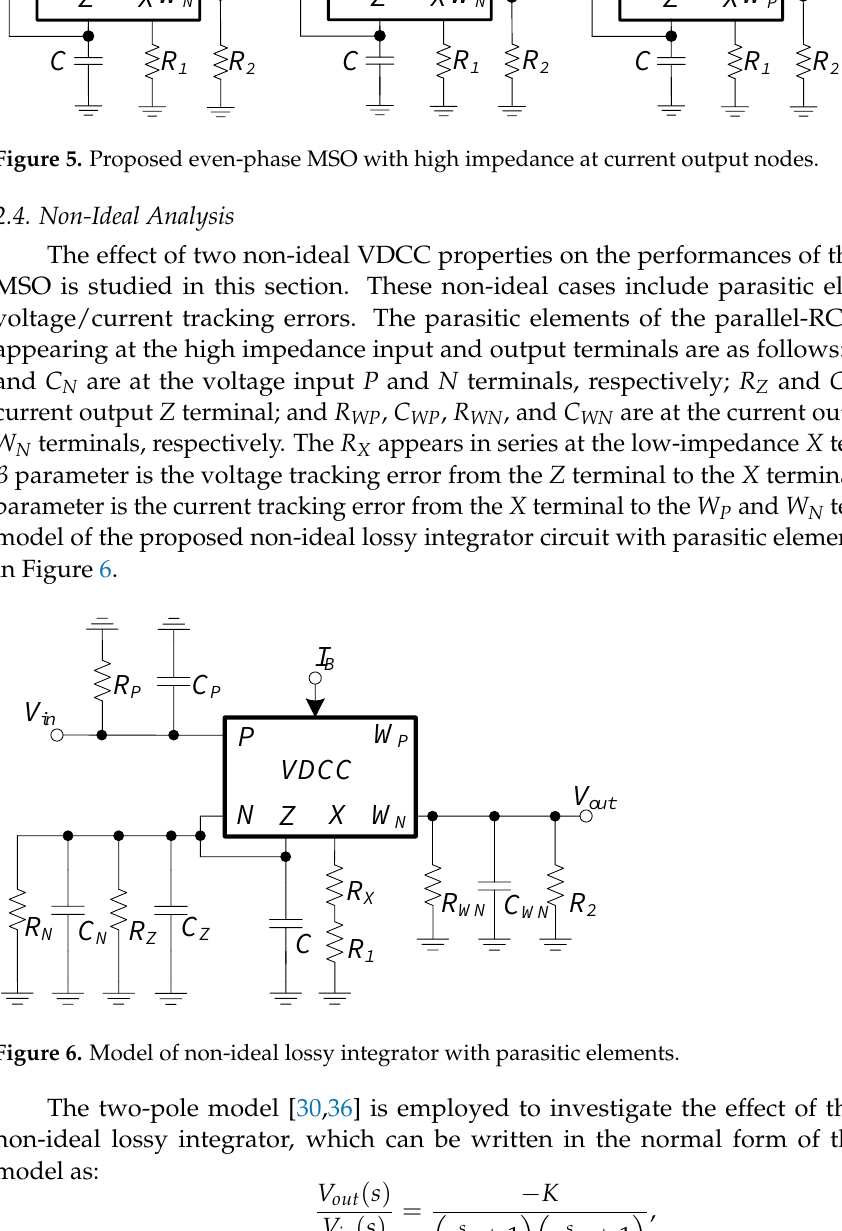
Figure 5. Proposed even-phase MSO with high impedance at current output nodes.